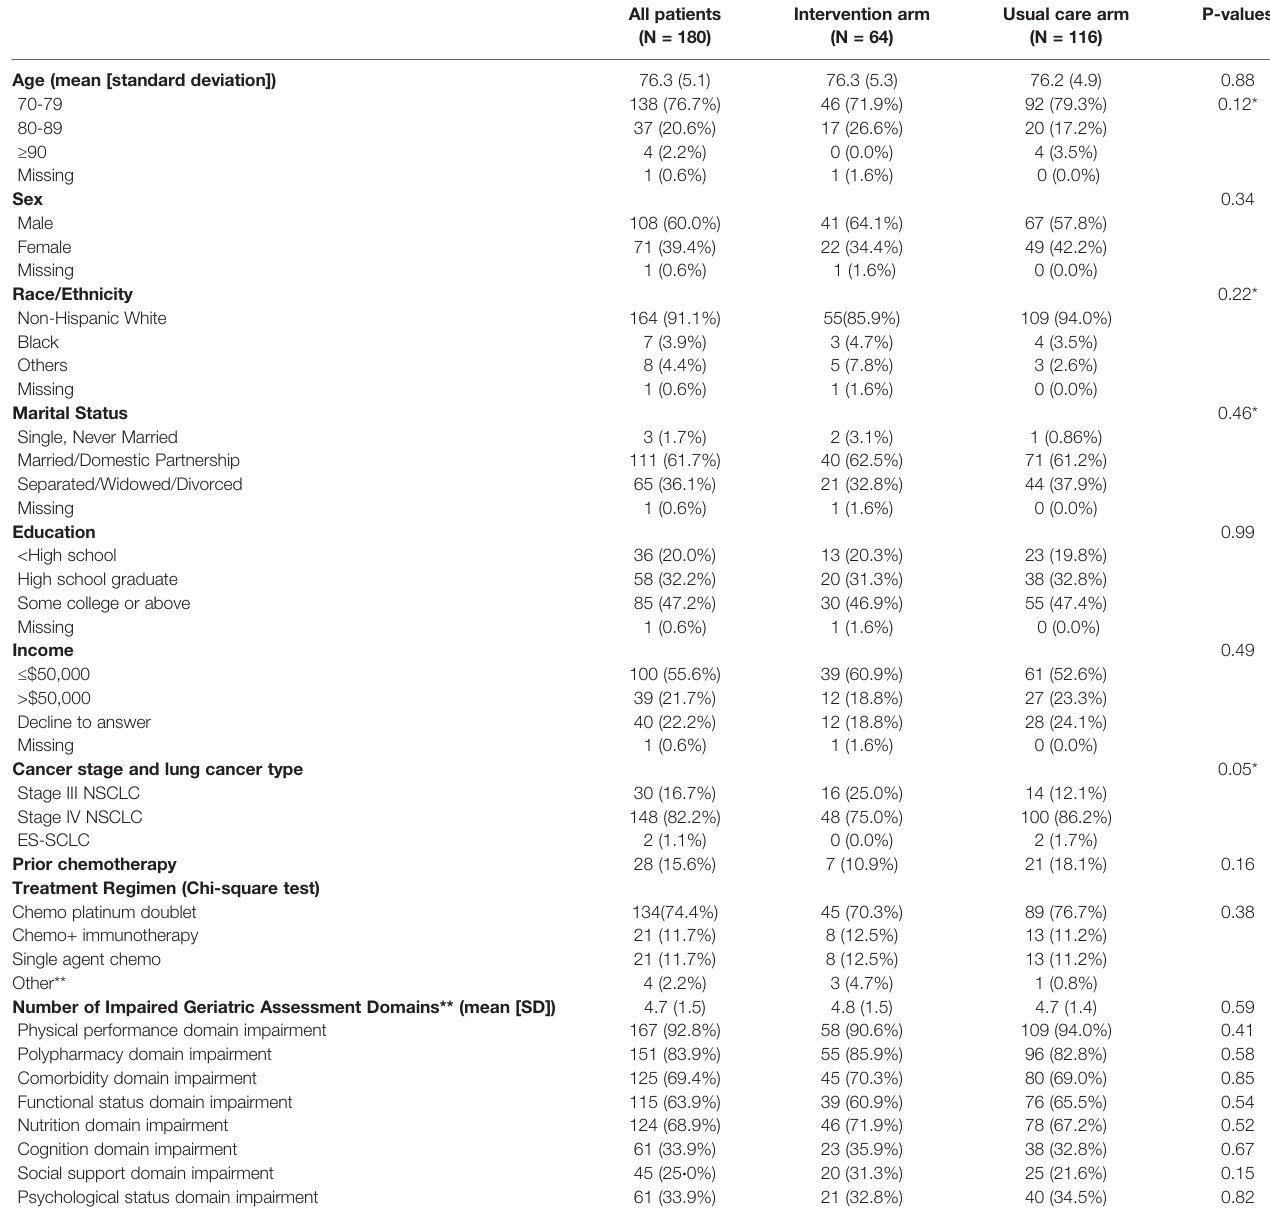
TABLE 1 | Patient Characteristics by Study Arm.